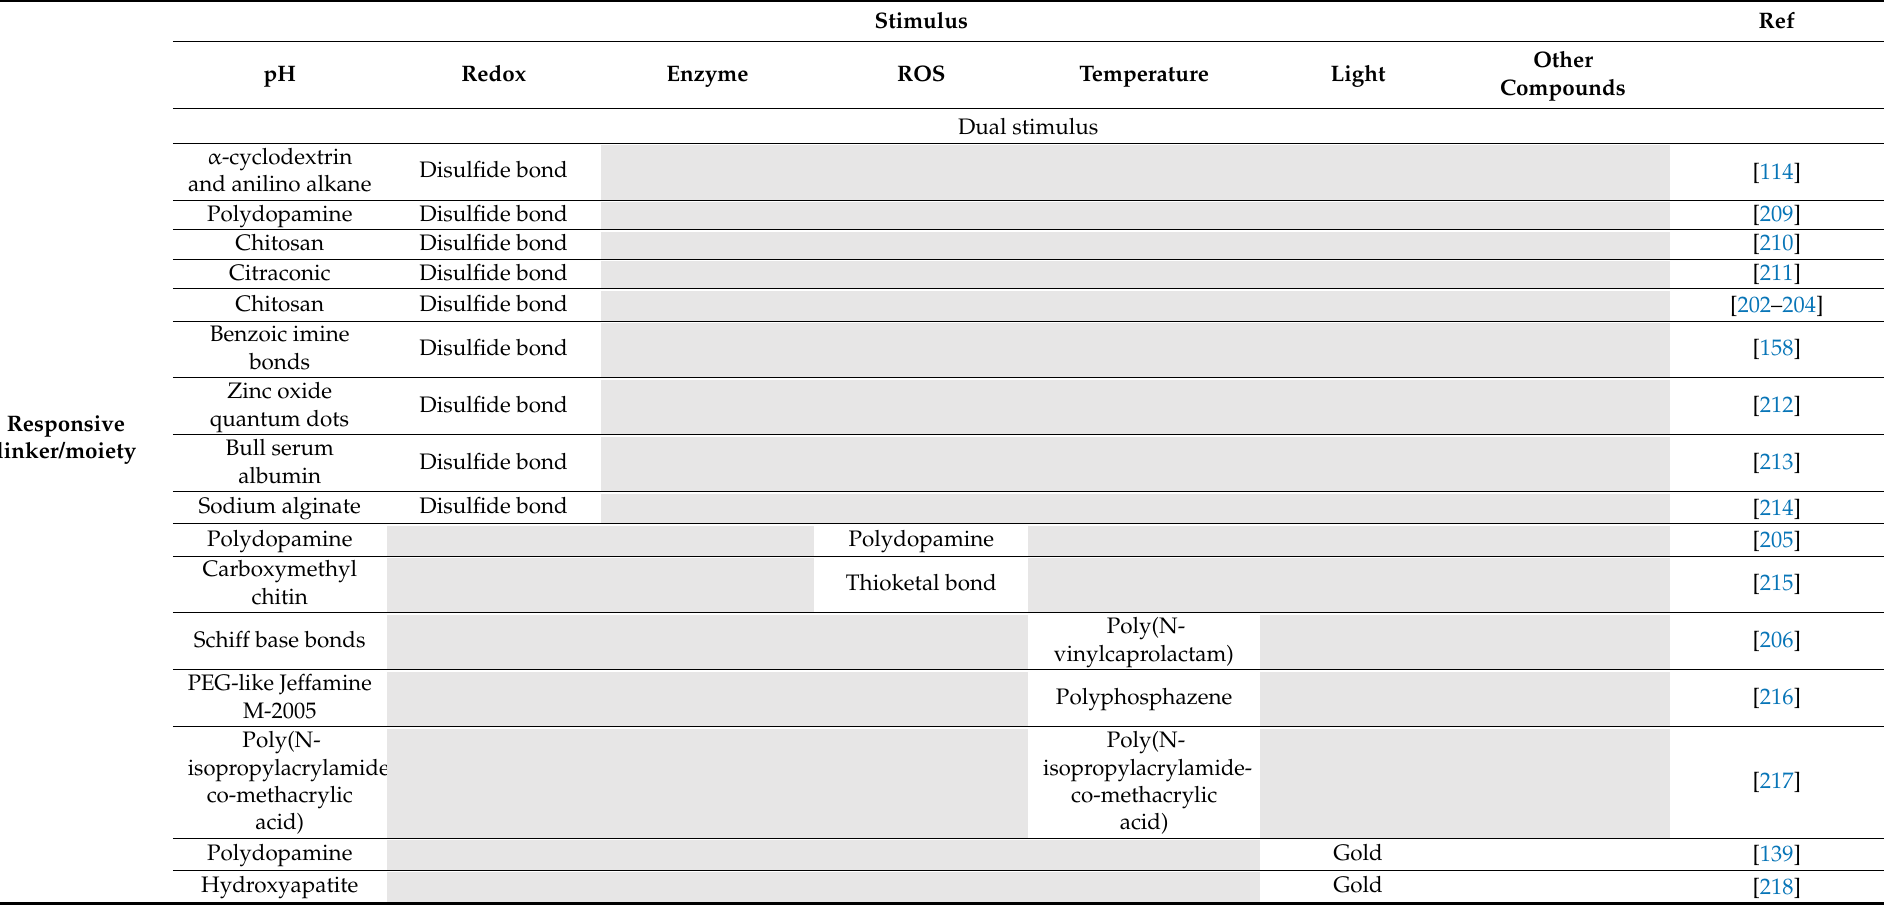
Table 3. Multiple responsive MSNs with their responsive